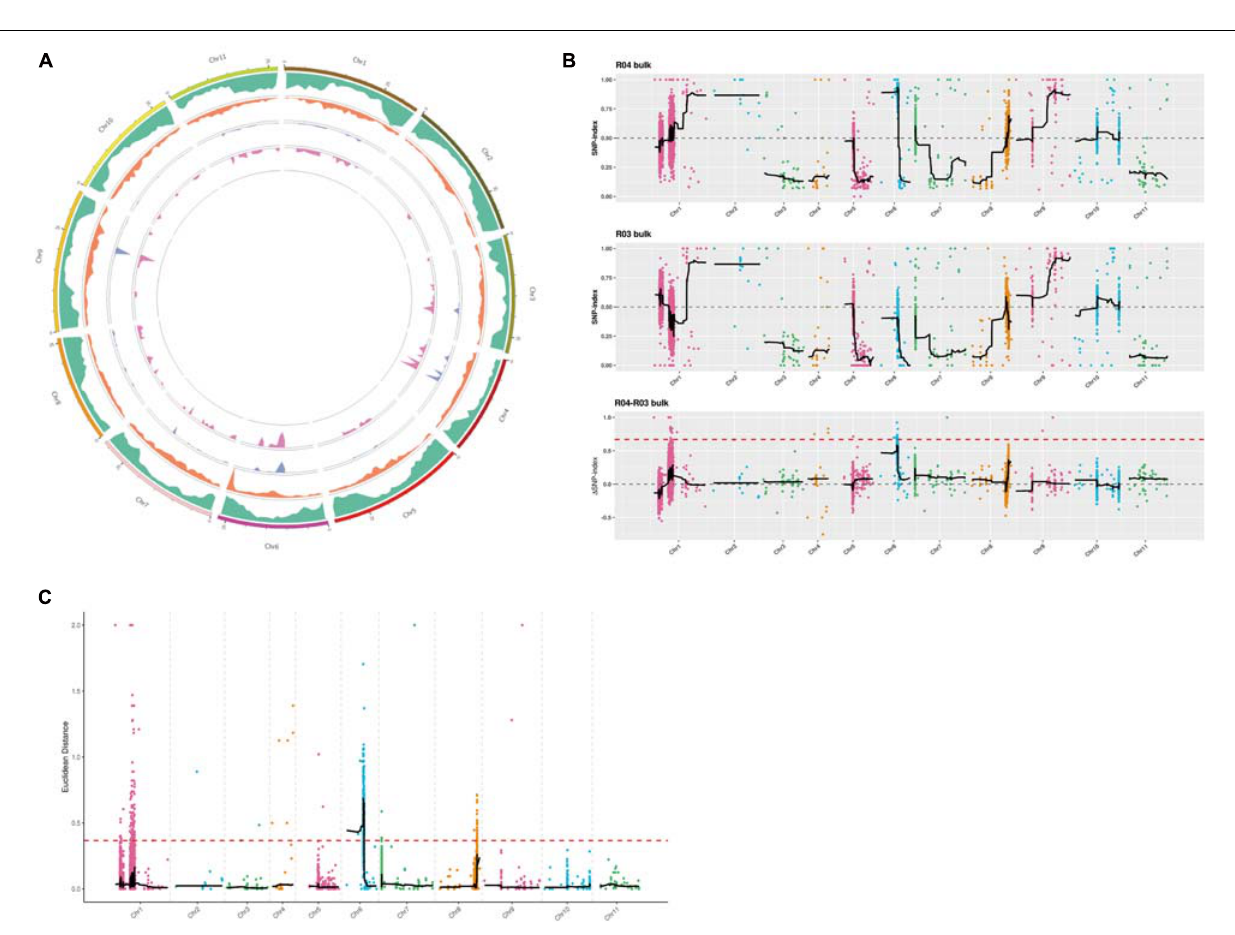
Frontiers in Plant Science |